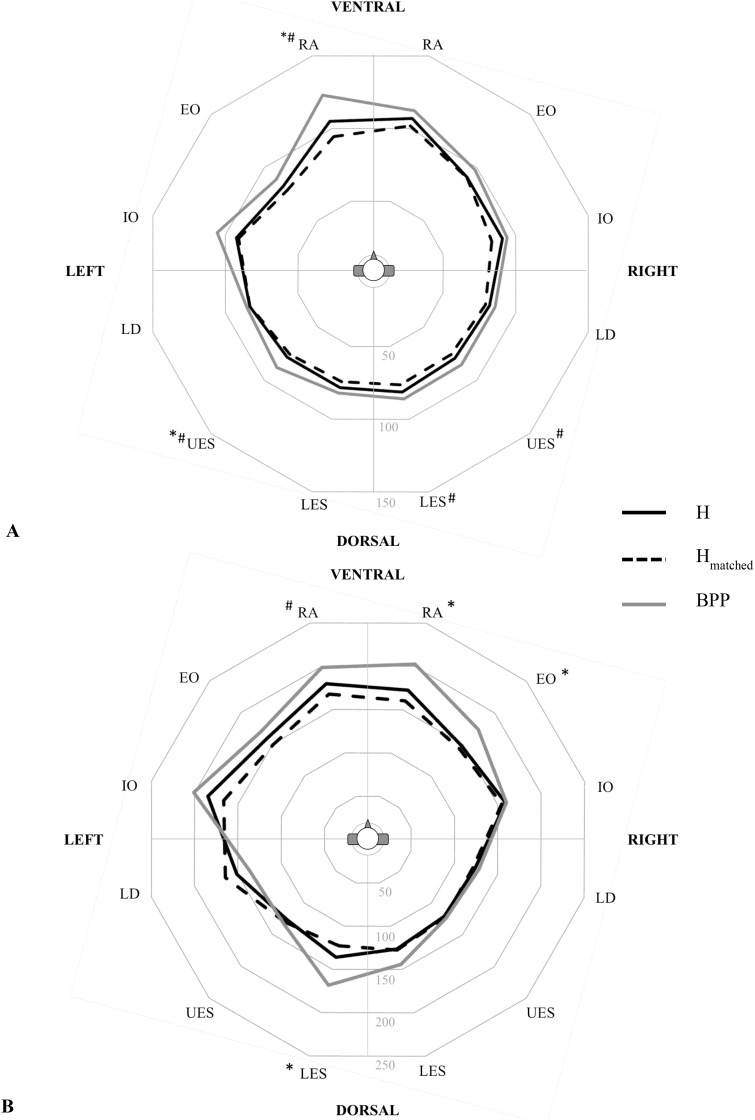
Polarplot of neuromuscular response time of 12 trunk muscles to perturbation.(A) onset of muscle activity (TON; ms) after perturbation. (B) time to maximum activity (TMAX; ms) after perturbation.* significant differences between H and BPP (p<0.025); # significant differences between Hmatched and BPP (p<0.025).